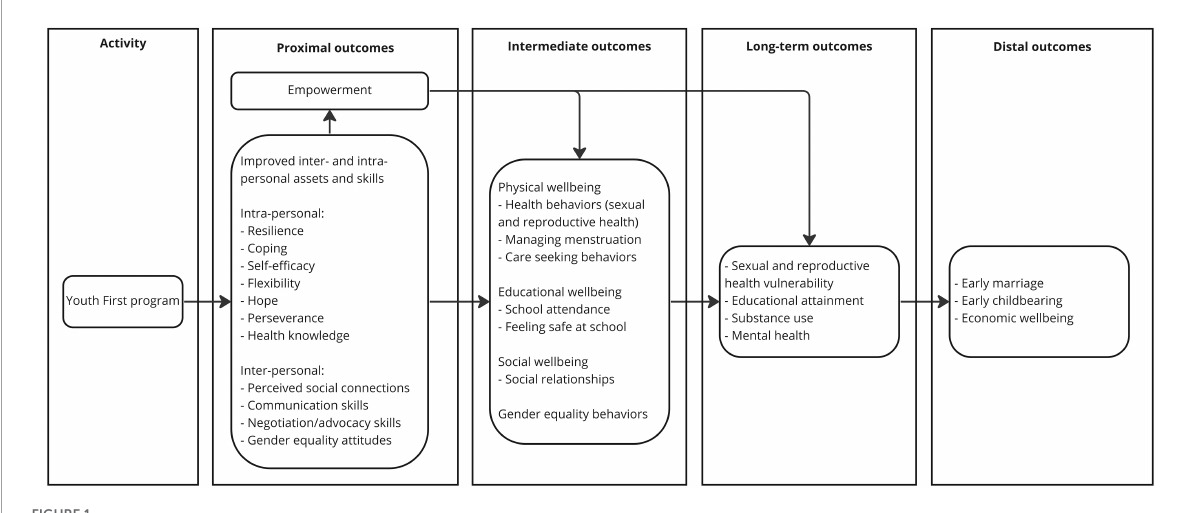
FIGURE1 Youth First theory of